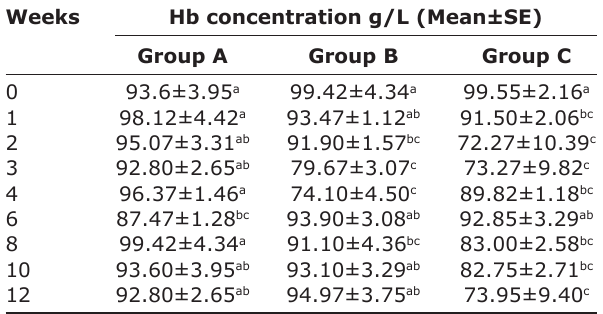
Table-2: Hb concentration in female goat’s postinoculation with C. pseudotuberculosis and MA. Weeks